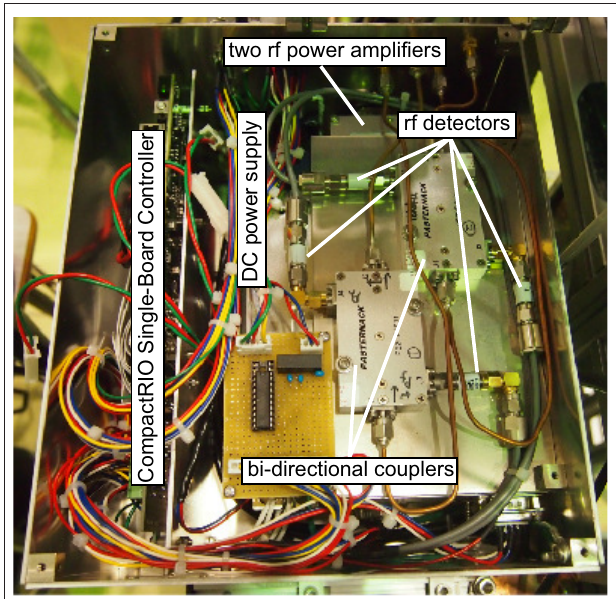
FIGURE 9 | Photograph of the rf system containing the two rf generators, the CompactRIO Single-Board Controller, and the dc power supply. The total size is within 220mm in width, 135mm in height, and 260mm in